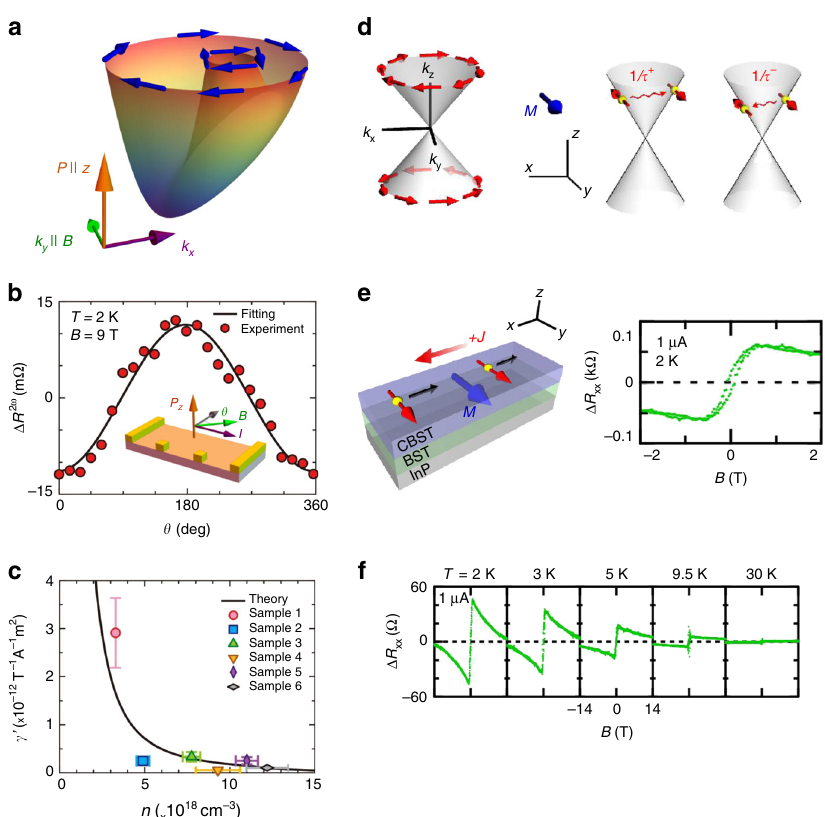
Fig. 4 Magnetochiral anisotropy in polar systems. a The distorted band structure of Rashba system under the external magnetic fi eld. When the polar axis is along the c -direction, the spin splitting occurs with the spin polarization for each band lying in the a – b plane. When the magnetic fi eld is applied along b axis, the asymmetry between two directions along a -axis appears 43 . b The dependence of the nonlinear resistivity corresponding to the γ term in Eq. (B1) on the direction of the external magnetic fi eld in BiTeBr, which is consistent with the formula R = R 0 [1 + γ ′ ( P × B ) ·I ] 43 . c The coef fi cient γ as a function of electron density in BiTeBr. The black curve is the theoretical calculation without any fi tting parameters. Figure from ref 43 . Reprinted with permission from Nature Publishing Group. d Schematics of the surface state of a three-dimensional topological insulator, which is described by the two-dimensional Weyl Hamiltonian with spin-momentum locking. With the in-plane magnetization along the y -axis, the inelastic scattering due to magnons to the right and left directions is different, leading to the nonreciprocal transport 45 . e The schematic experimental setup (left), and the obtained magnetic fi eld dependence of the nonlinear resistivity 45 . f Magnetic fi eld dependence of nonlinear resistivity at several temperatures. Reprinted fi gure with permission from ref 45 . Copyright (2016) by the American Physical